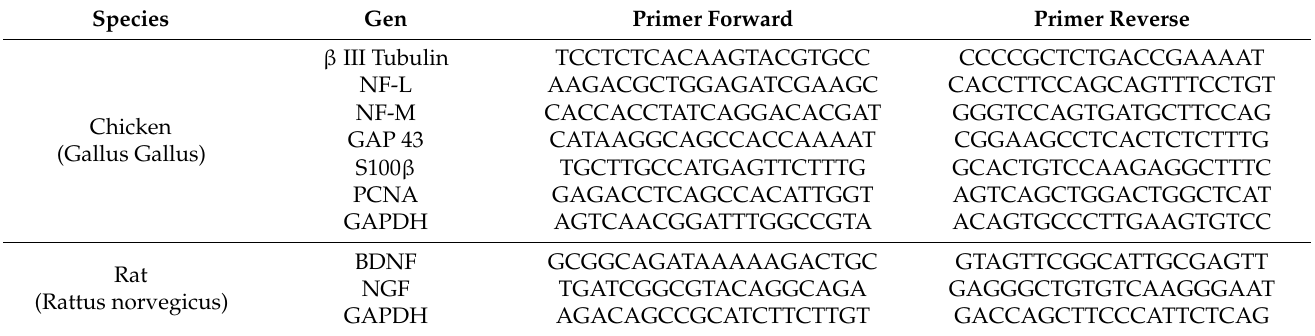
Table 2. Primer sequences for the chicken and rat target genes that were